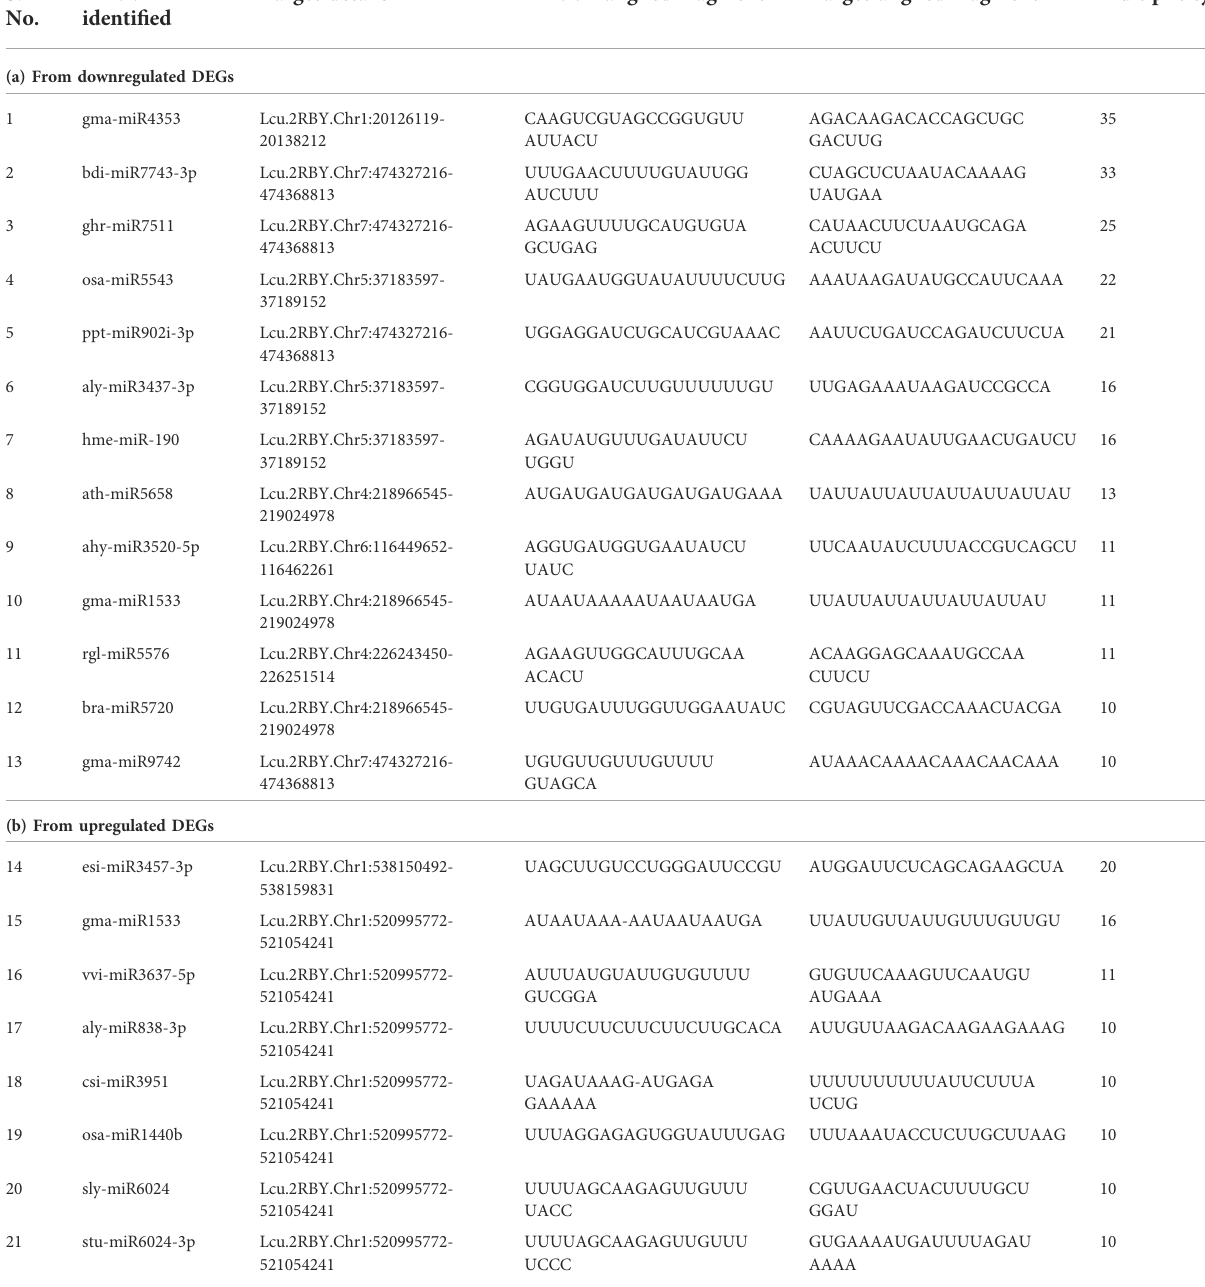
TABLE 4 List of miRNAs and the target fragment identi fi ed from the RNA-seq data generated for seed size variations. S.